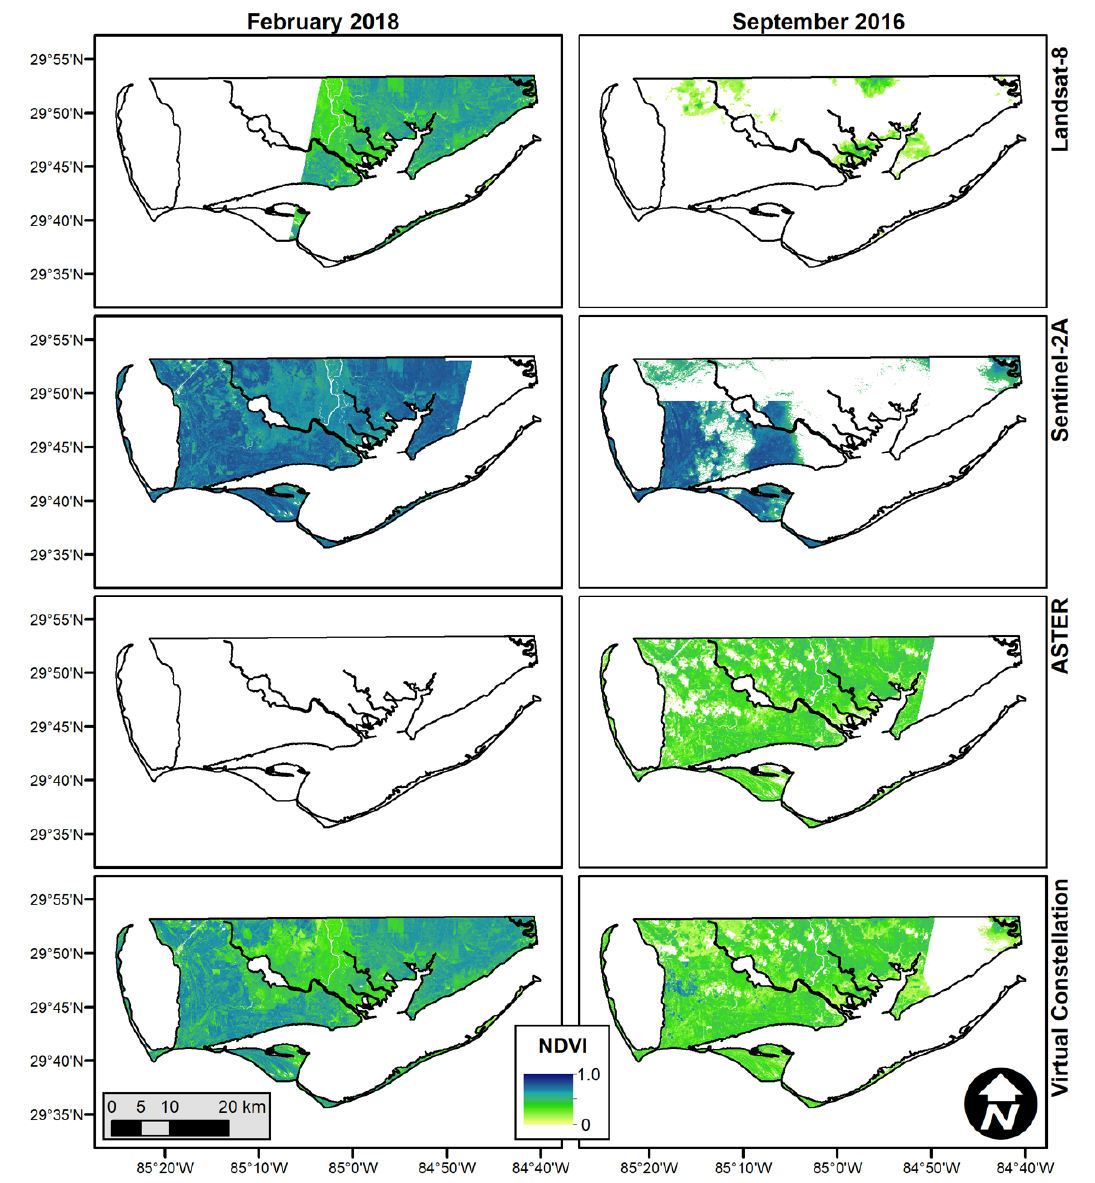
Figure 8. Virtual Constellation performance for February 2018 and September 2016. White pixels in the project area indicate information loss due to clouds, shadows, or scene missing in that month.